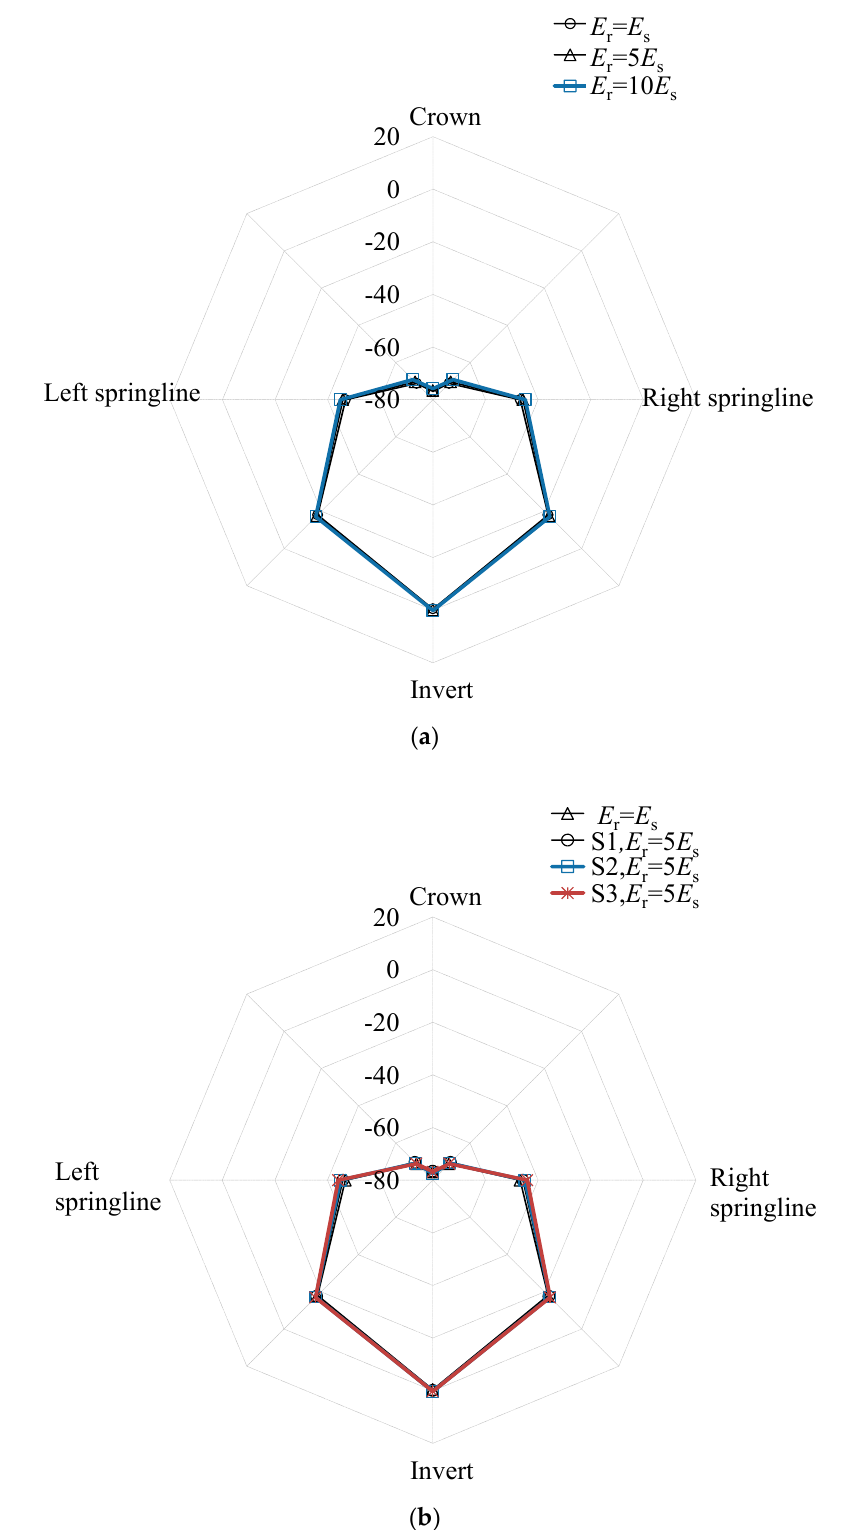
Figure 11. Computed earth pressure change in the soil element along the tunnel transverse direction for ( a ) different reinforcement Young’s moduli and ( b ) different reinforcement depth.